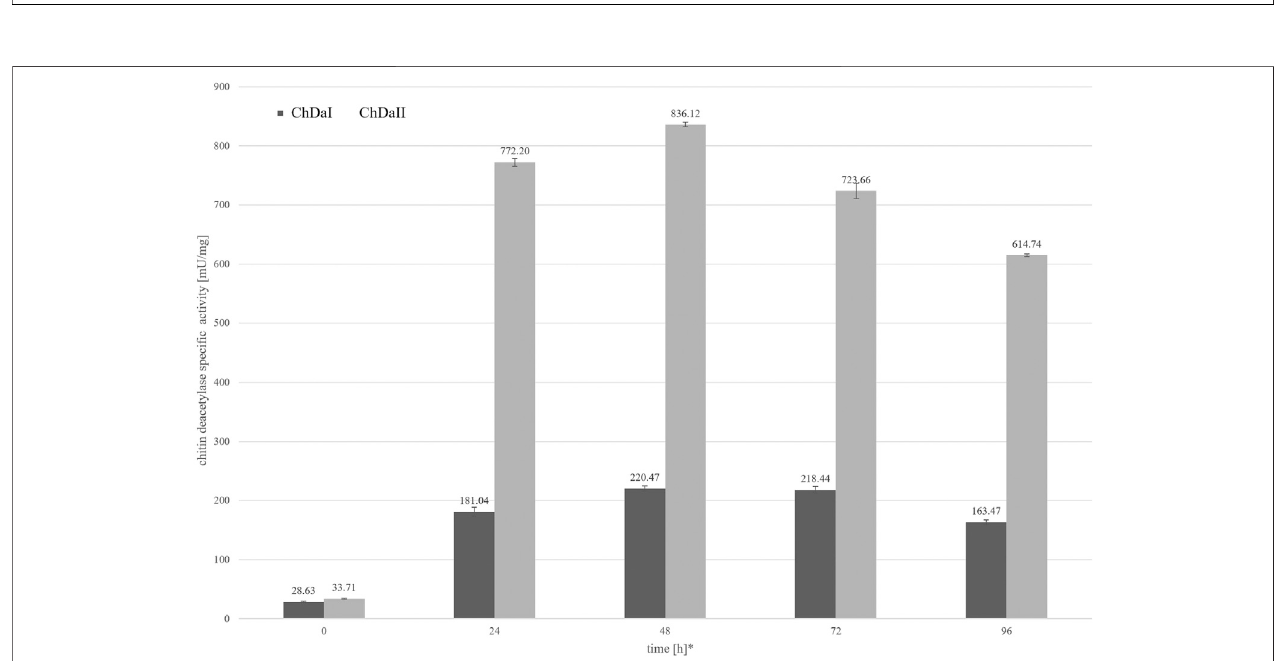
FIGURE 4 | Relationship between the speci fi c activity of chitin deacetylases and the time of cultivation. The enzymatic preparations were made from the culture medium obtained after the cultivation of transformants exhibiting the highest chitin deacetylases activity. * Cultivation time measured from the start of methanol-induced expression of ChDaI and